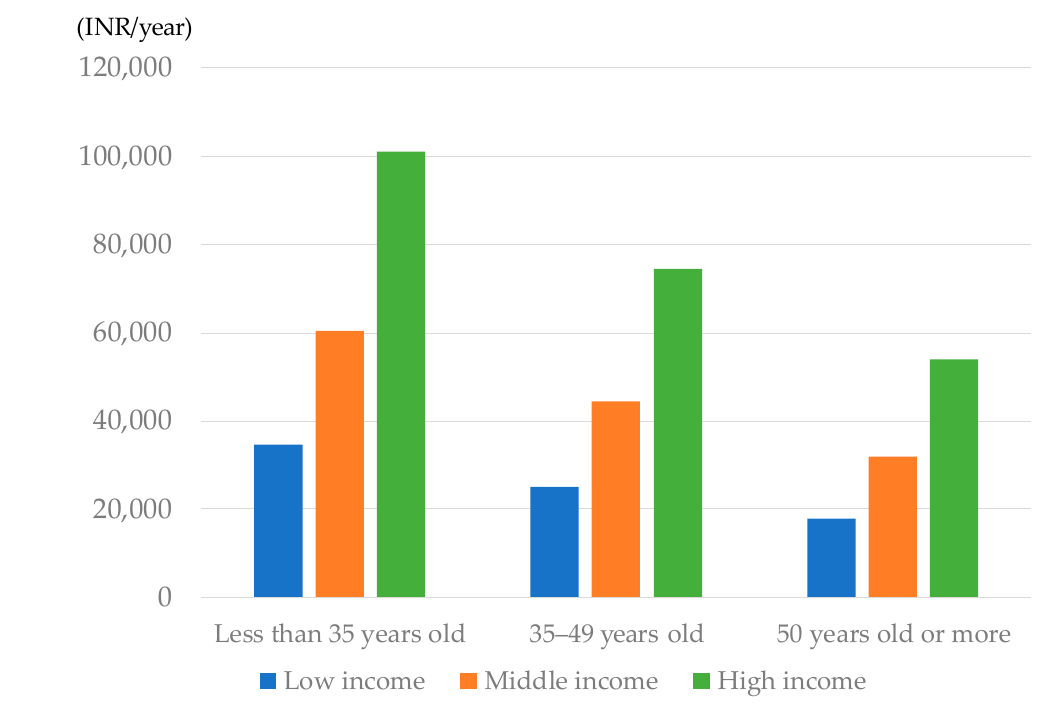
Figure 7. Averaged personal QOL increased by age and income class.